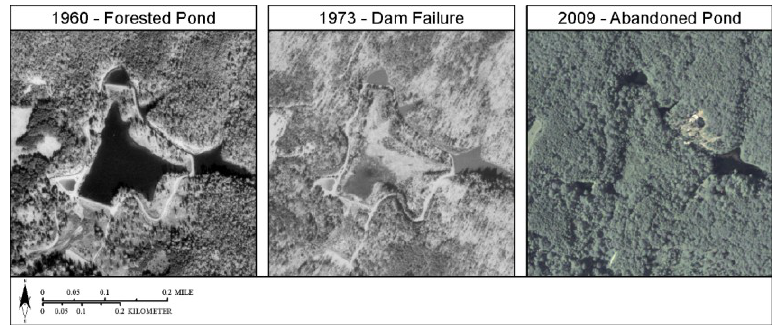
Figure 9. Example of small reservoir failure and abandonment.